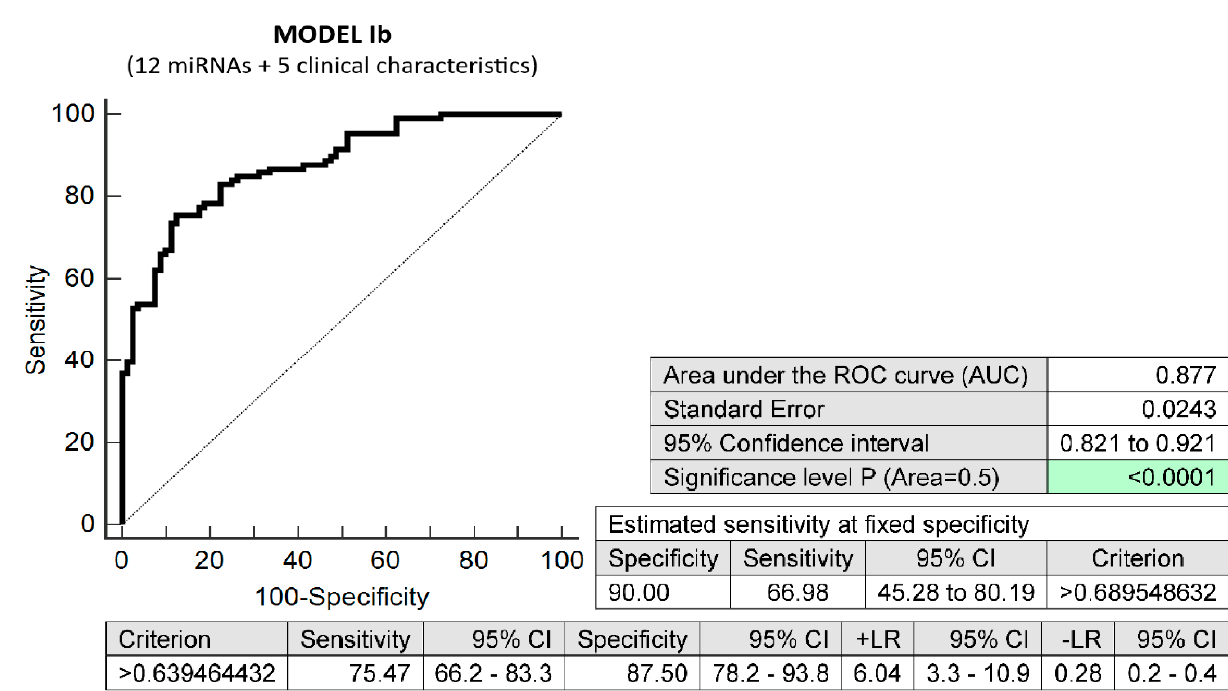
Figure 3. ROC analysis—prediction model Ib for preterm birth before 37 gestational weeks. Combination of five basic maternal clinical characteristics (age and body mass index values at first trimester of gestation, treatment of infertility with techniques of assisted reproduction, preterm birth <37 gestational weeks in previous pregnancy(ies), and the presence of any kind of autoimmune disease (RA, SLE, APS, T1DM, or other autoimmunity)) and 12 dysregulated microRNA biomarkers (miR-16-5p, miR-20b-5p, miR-21-5p, miR-24-3p, miR-26a-5p, miR-92a-3p, miR-133a-3p, miR-145-5p, miR-146a-5p, miR-155-5p, miR-210-3p, and miR-342-3p). In total, 66.98% of pregnancies destined to deliver before 37 gestational weeks were identified during the first trimester of gestation with a 10.0% FPR.